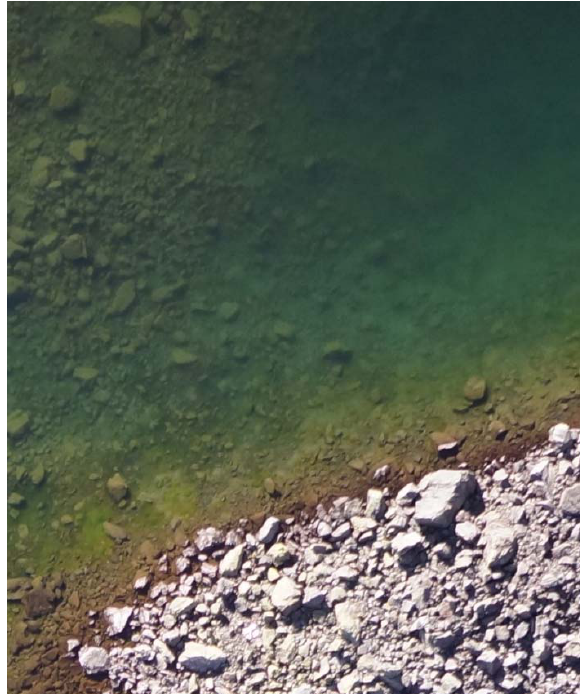
Figure 8: Varying imaging-quality of onshore and underwater areas.